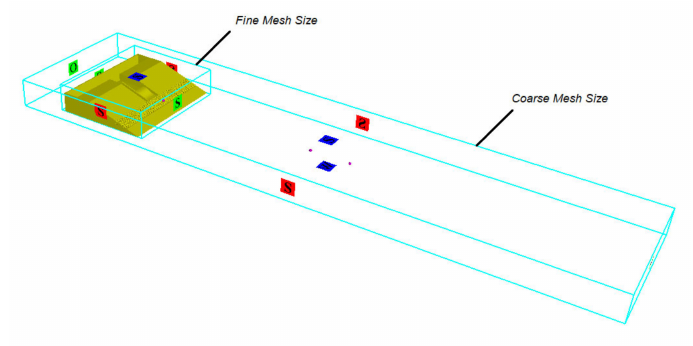
Figure 9. Boundary and mesh condition in Flow 3D